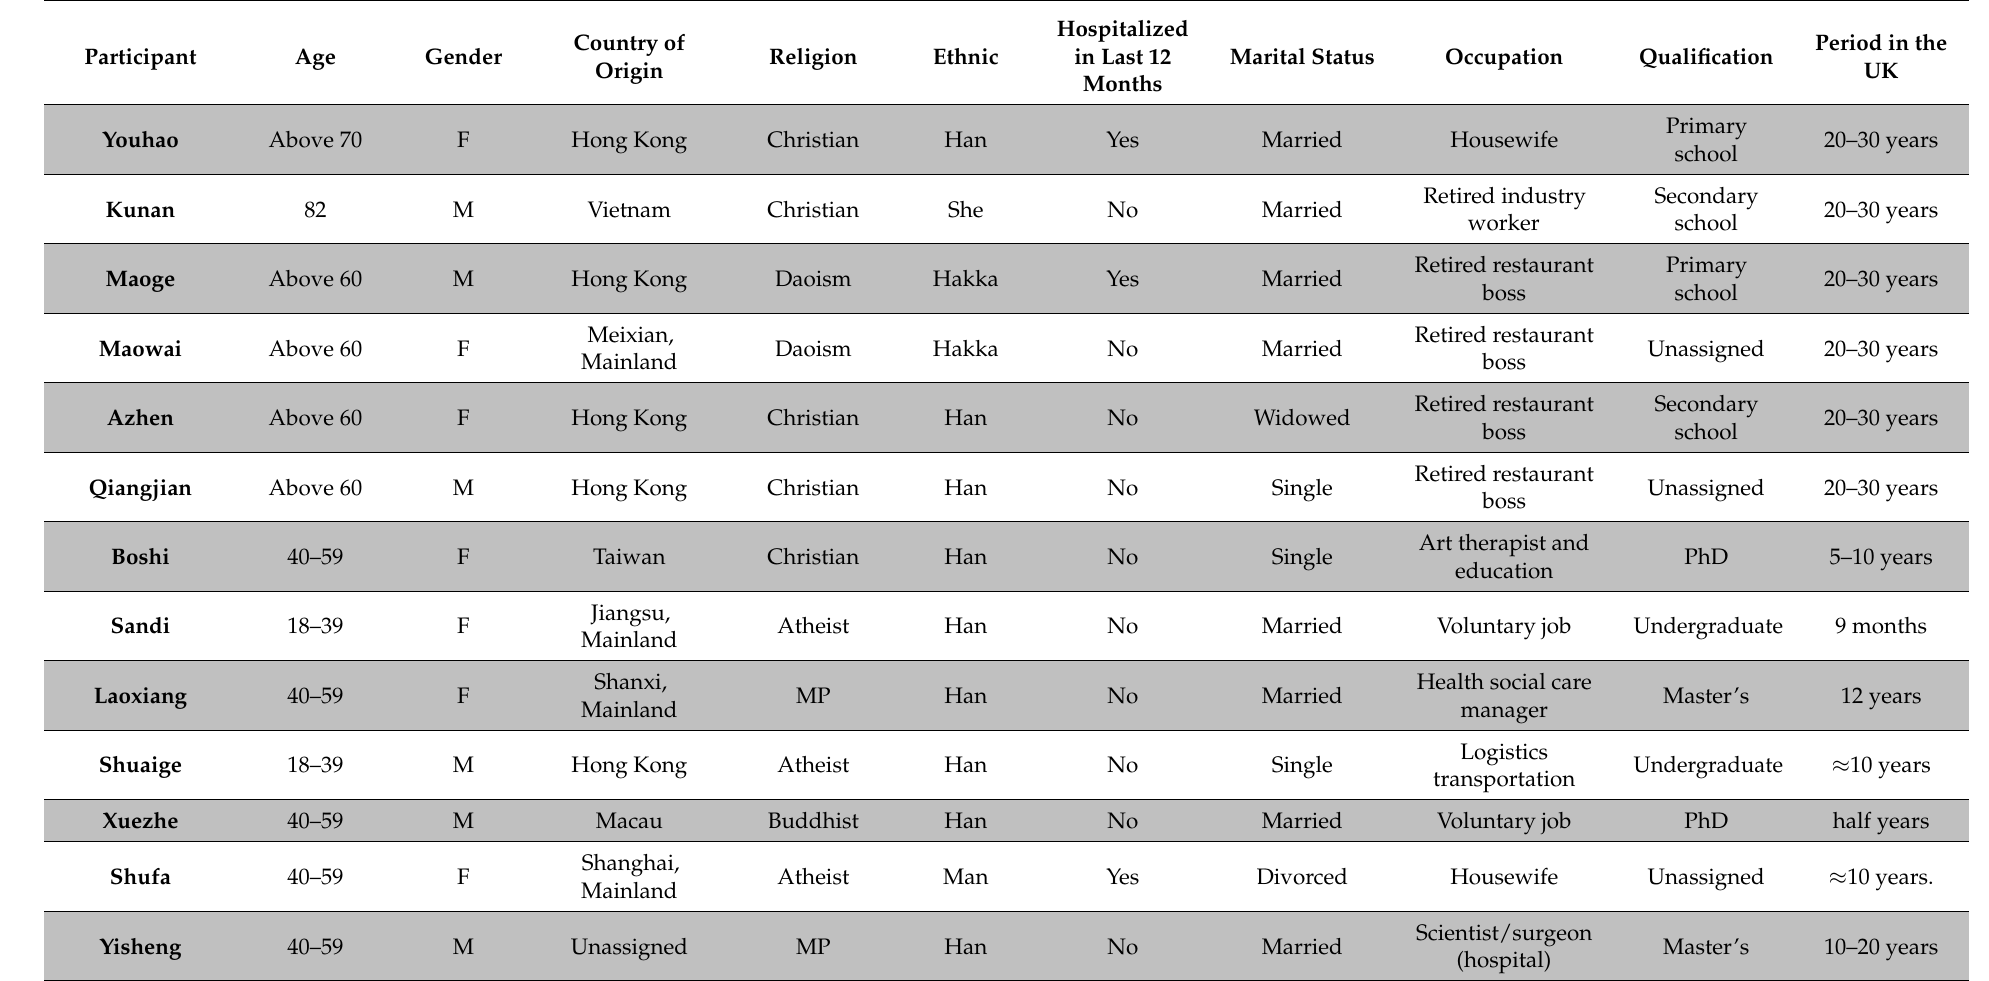
Table 1. Participants’ demographic